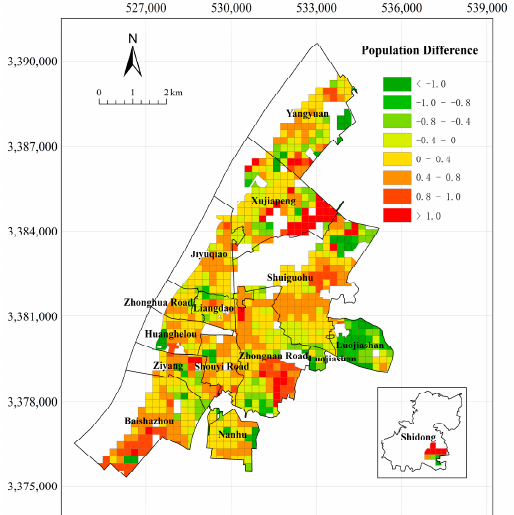
Figure 11. Population Difference According to Cross-validation Analysis.